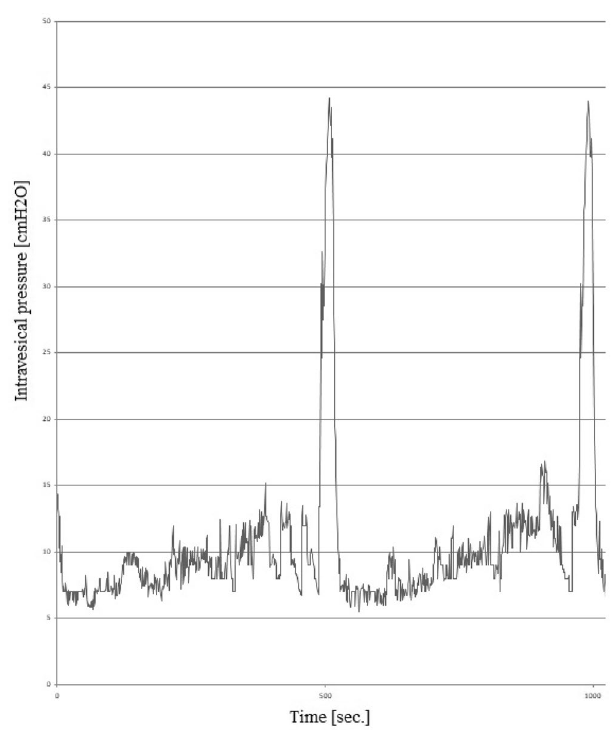
Figure 2. Cystometrogram in rats with cyclophosphamide (CYP)-induced detrusor overactivity. The figure shows a 1000-s interval (horizontal axis). The vertical axis is the intravesical pressure (range: 0–50 cmH 2